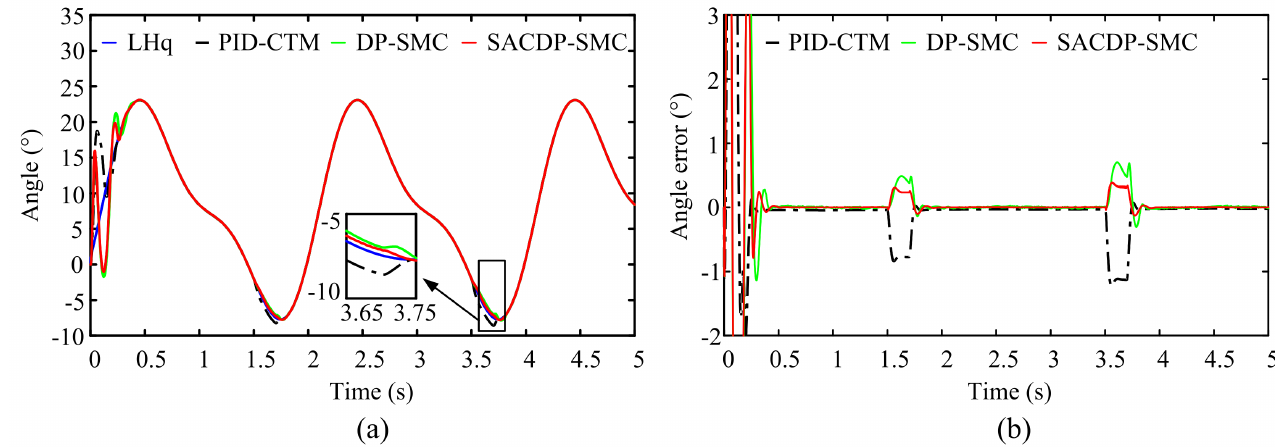
Figure 7. The angle tracking curve and error of the left hip. ( a ) The tracking curve of the left hip; ( b ) The tracking error of the left hip.